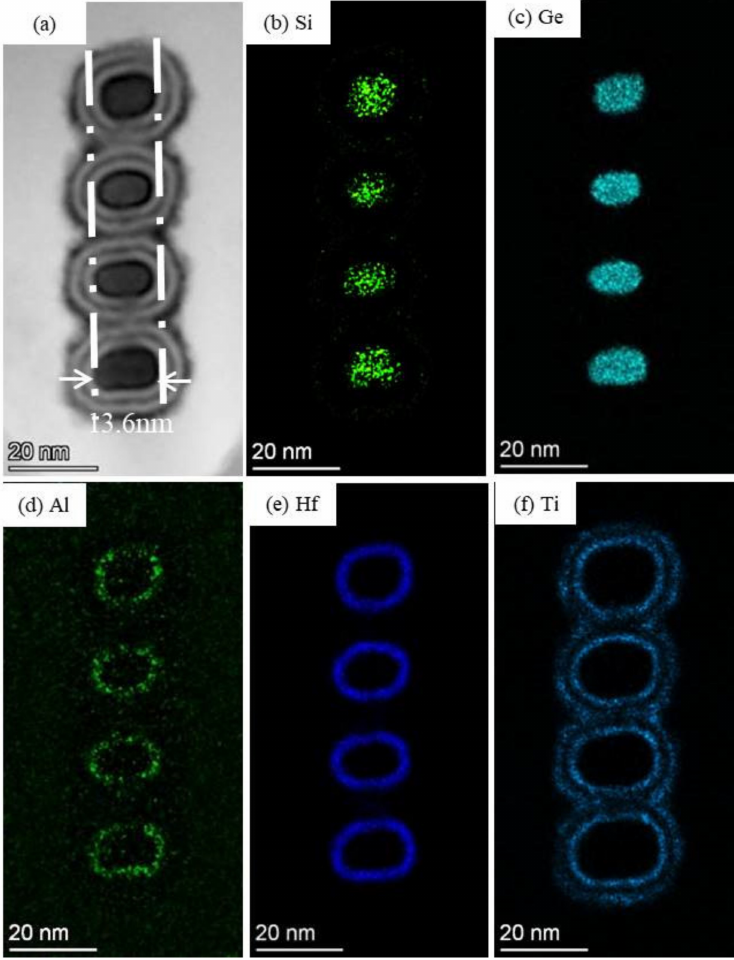
Figure 6. ( a ) The enlarged view of the channel area at across the fin direction and ( b – f ) the EDX mapping of the 4-levels vertically stacked Si 0.7 Ge 0.3 NWs GAA device under the HK/MG stacks at the end of the fabrication processing.